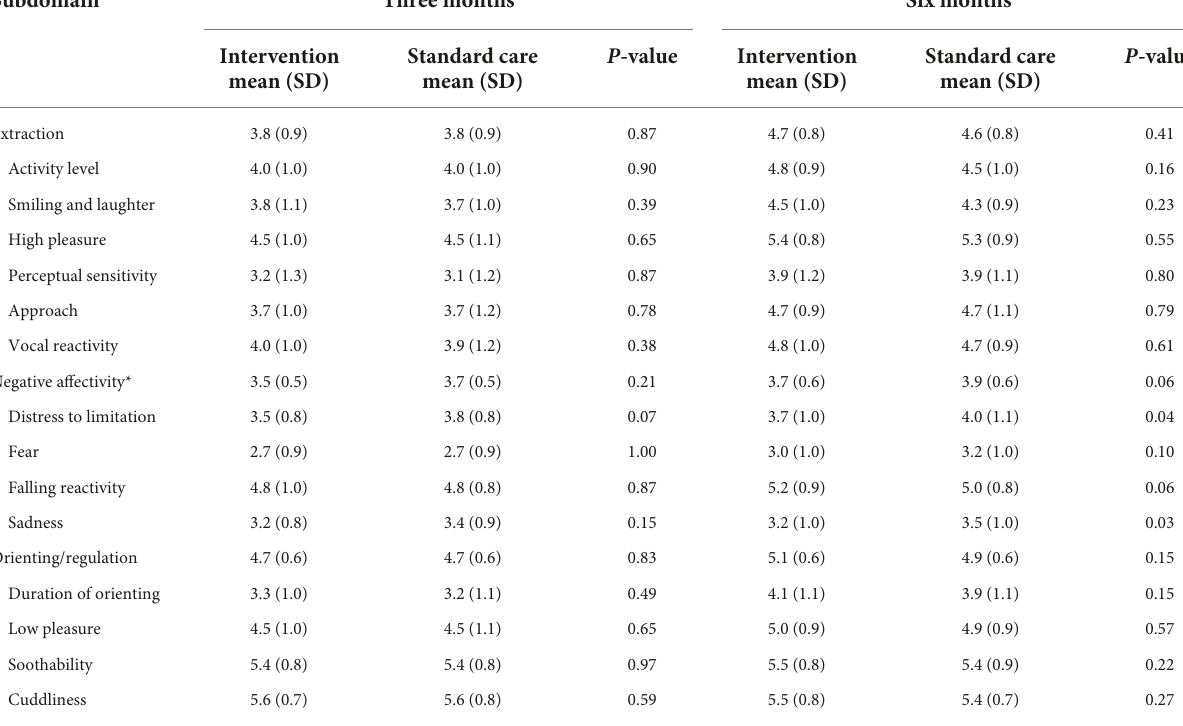
TABLE 2 Comparison of temperament subdomain scores at 3 and 6 months between the two groups.